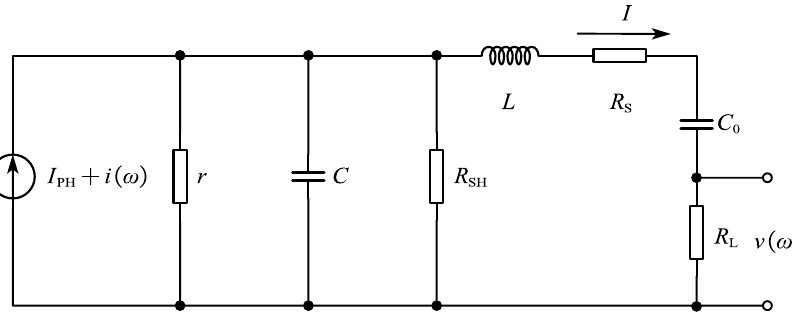
Figure 3. AC model of the solar cell in the communication system. i ( ω ) is the photocurrent generated by the solar cell from the received signal, C is the junction capacitance of the solar cell and L is the equivalent inductance introduced by